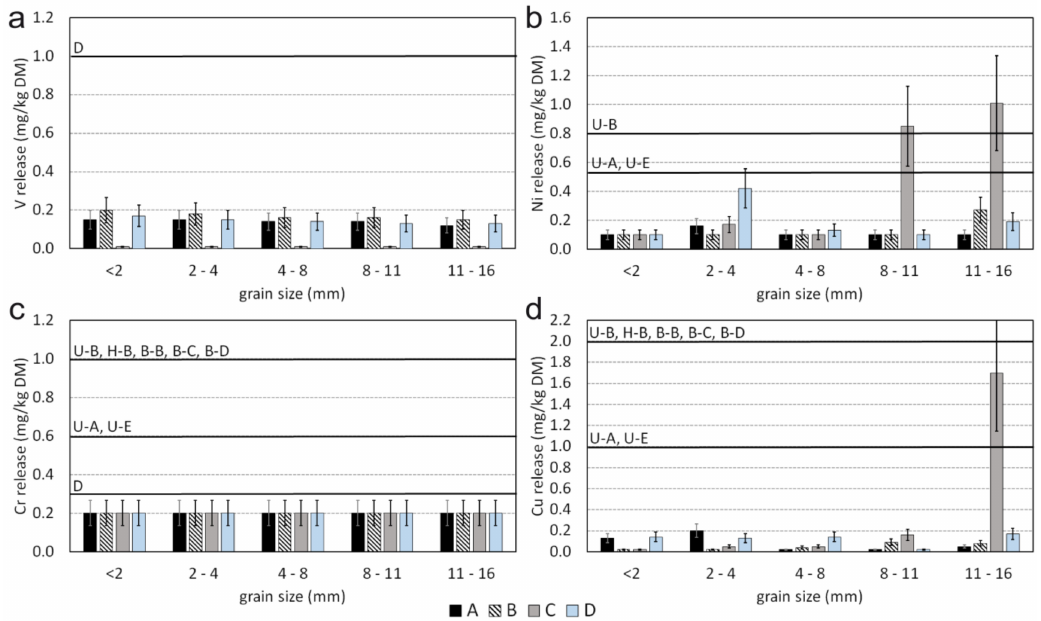
Figure 6. Leachable contents of individual particle size fractions of samples A–D at natural pH with limit values for di ff erent quality classes according to the RCMO: ( a ) vanadium, ( b ) nickel, ( c ) chromium, ( d ) copper; U-A unbound application, U-B unbound application underneath a low permeable cover layer, U-E unbound application in road construction, H-B concrete aggregate, B-B asphalt planings for unbound application, B-C asphalt aggregate, B-D slag-containing asphalt, D slags directly from